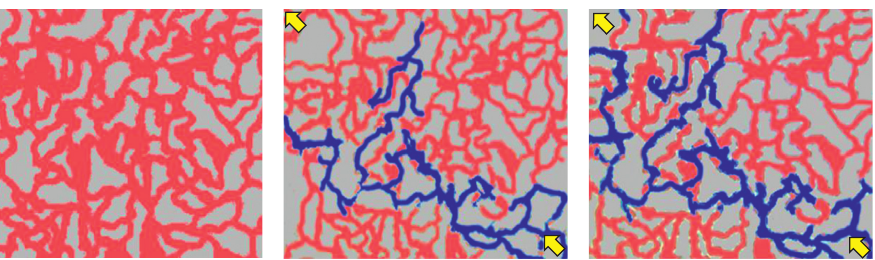
Figure 5: Schematic diagram of the early, middle, and late stages of water injection in porous reservoirs.